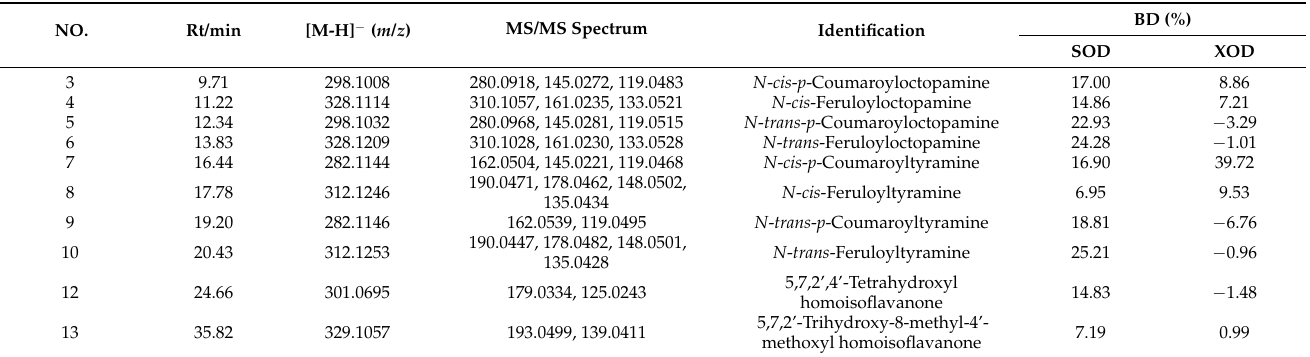
Figure 3. The UF-LC-UV chromatograms of the EA fraction from P. sibiricum with xanthine oxidase (XOD) at 280 nm. The black line represents UPLC profiles of EA fraction, the red and blue lines represent activate and inactivate XOD, respectively. Table 2. The identification, binding degree (BD) and the UF-LC-MS/MS data of potential SOD and XOD ligands screened out from P. sibiricum